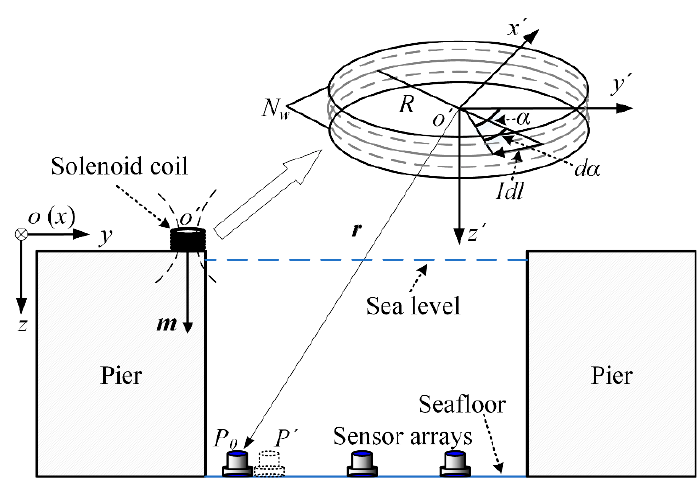
Figure 1. The sensor array arrangement and the solenoid coil setup.